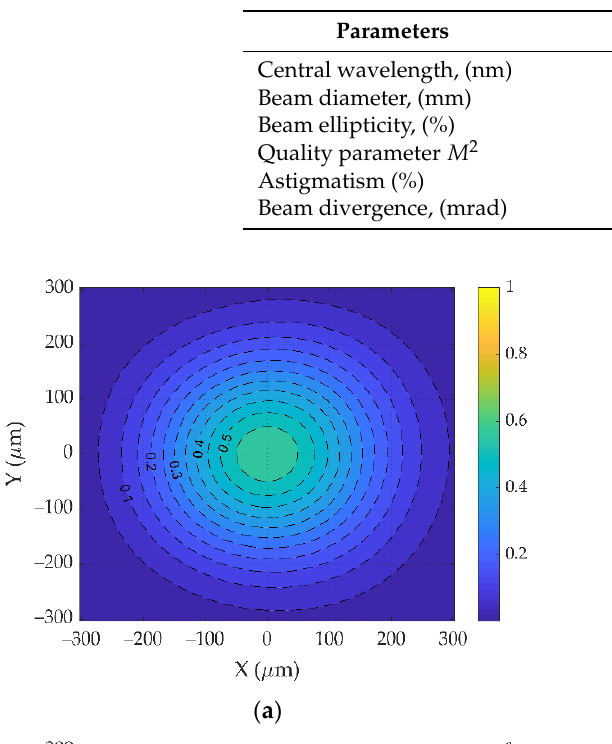
Table 2. Datasheet for the Satsuma laser.